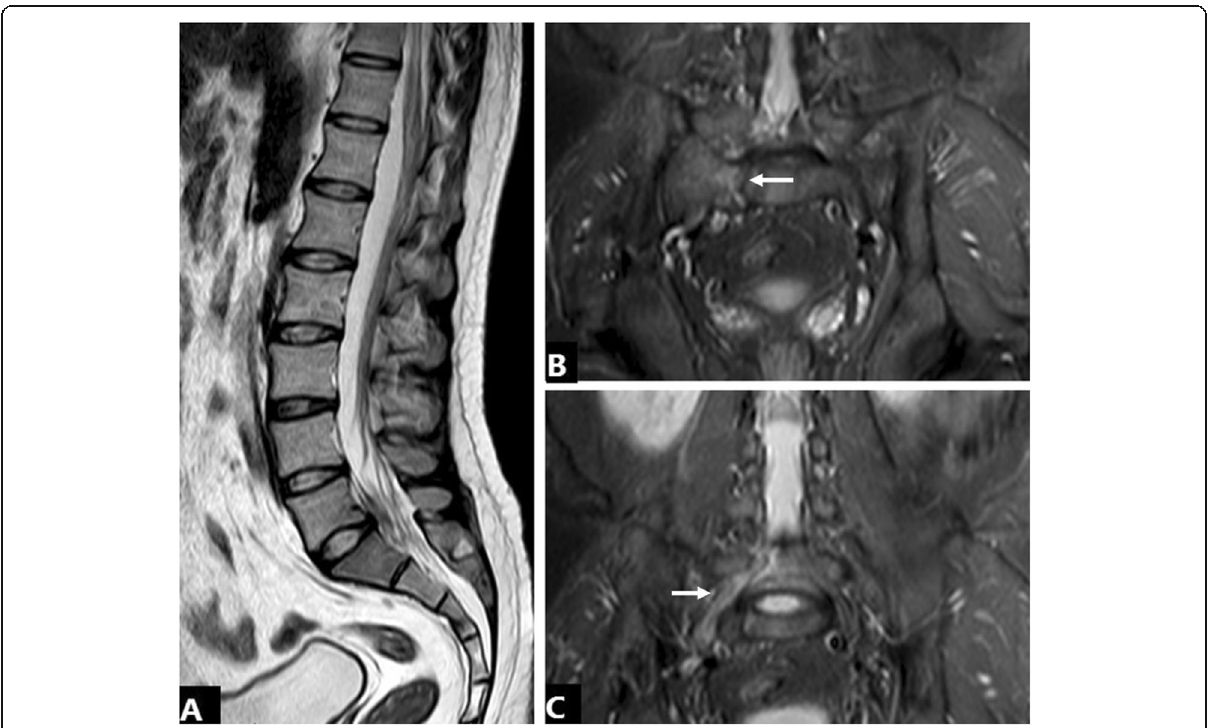
Fig. 3 A 30-year-old male patient, presenting with right sciatica. a Routine MR protocol images revealed mild thickening of the cauda equina nerve roots opposite S1 segment. b , c Additional coronal STIR images revealed marrow edema and a stress fracture at the right sacral alum (arrow in b ) and thick edematous right S1 nerve root (arrow in c )